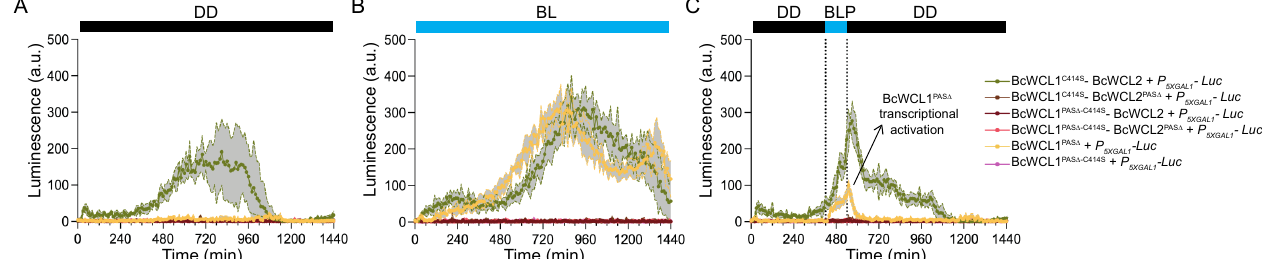
Figure 5. The BcWCL1 and BcWCL1 PAS ∆ proteins are capable of blue-light sensing. The BcWCL1 protein carrying the C414S mutation (BcWCL1 C414S ) or its version without PAS domains and con- taining the C414S mutation (BcWCL1 PAS ∆ -C414S ) were assayed for protein–protein interaction with the full length BcWCL2 or its variant without PAS domain (BcWCL2 PAS ∆ ), respectively. The individual contribution of BcWCL1 PAS ∆ in the light-mediated transcriptional activation was included as control. Luciferase expression was measured as luminescence in arbitrary units (a.u.) of the yeast cell cul- tures. The protein–protein interaction activates luciferase expression controlled by the 5XGAL1 syn- thetic promoter (P 5XGAL1 ) under three different conditions: ( A ) constant darkness (DD), ( B ) constant blue light (BL), and ( C ) a single blue-light pulse of 2 h duration (between dotted lines). In all panels, the average of six biological replicates is shown, with standard deviation represented as shadowed regions.